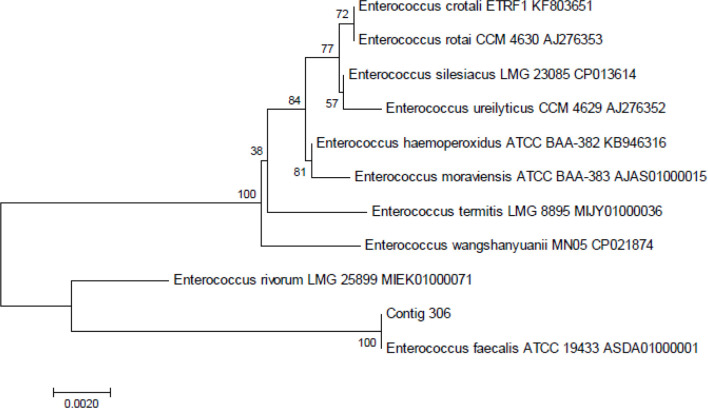
16S rRNA gene sequence-based phylogenetic tree for
E. faecalis
 strain LMEM 306 (contig 306) compared with the sequences of closely related reference bacterial strains retrieved from the NCBI’s GenBank database. Digits shown at the nodes represent the bootstrap values (for a total of 1000 replicates).